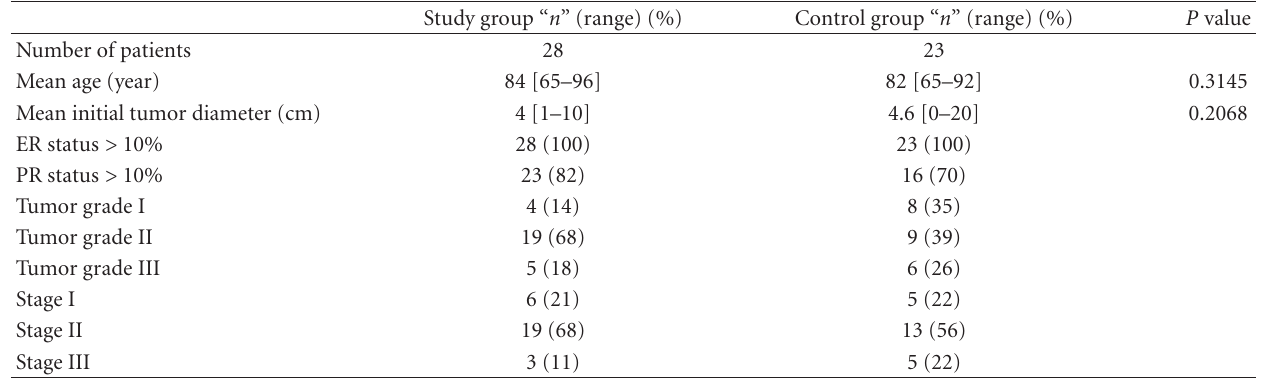
Table 1: Population characteristics.